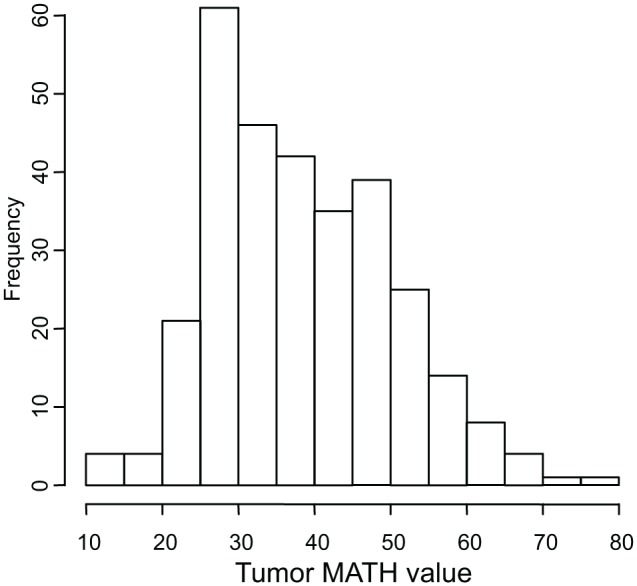
Histogram of MATH values among 305 HNSCCs.Horizontal axis, MATH values; vertical axis, number of tumors having MATH values within the indicated ranges.